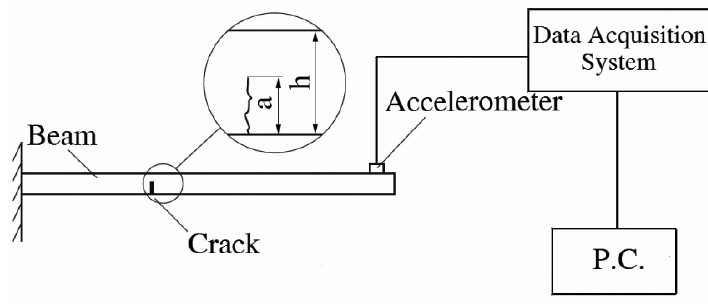
Fig. 9. Set-up of the experimental apparatus.